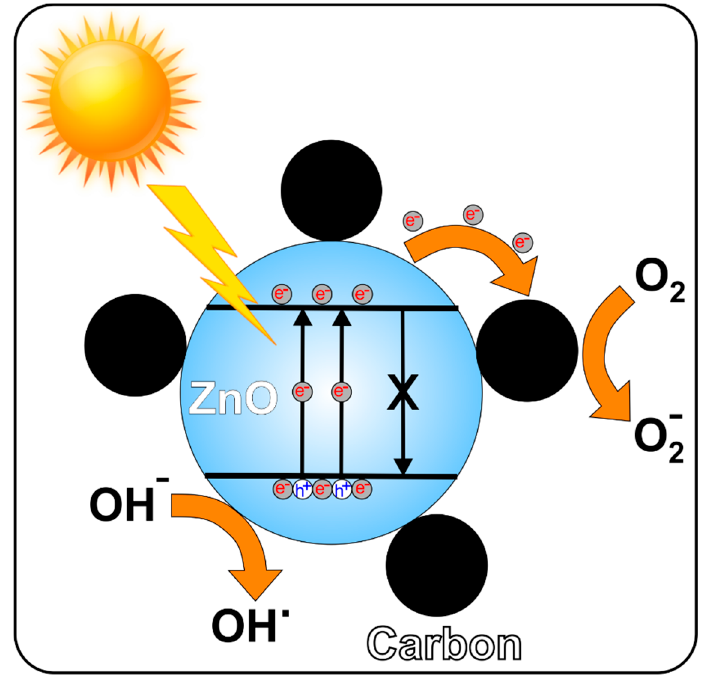
Figure 12. Proposed mechanisms of the photocatalysis of the carbon/ZnO nanostructures.